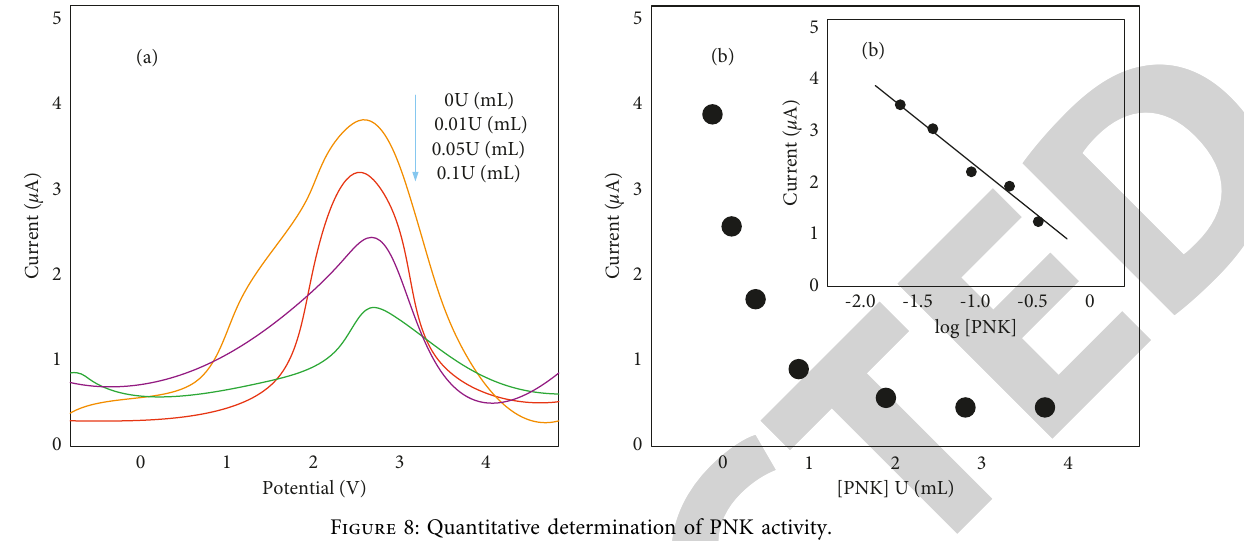
Figure 8: Quantitative determination of PNK activity.